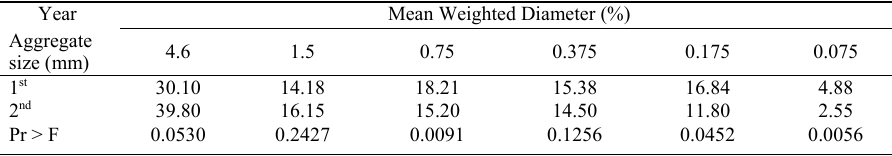
Table 3: Change in soil aggregate size distribution within first and third years (t-test) in the study area